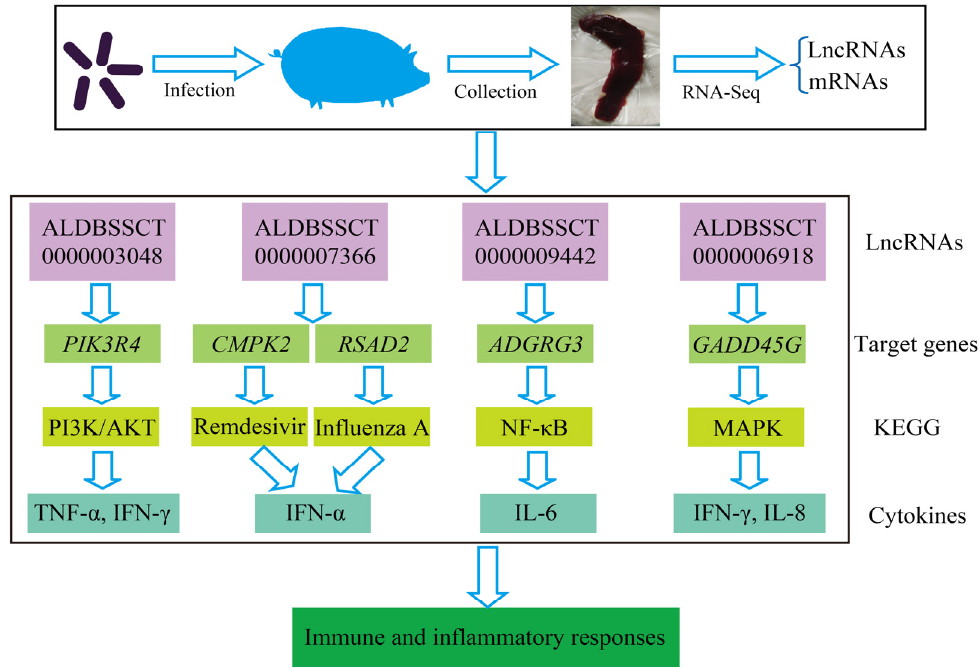
Figure 11. A diagram illustrating the potential lncRNAs, target genes and cytokines.